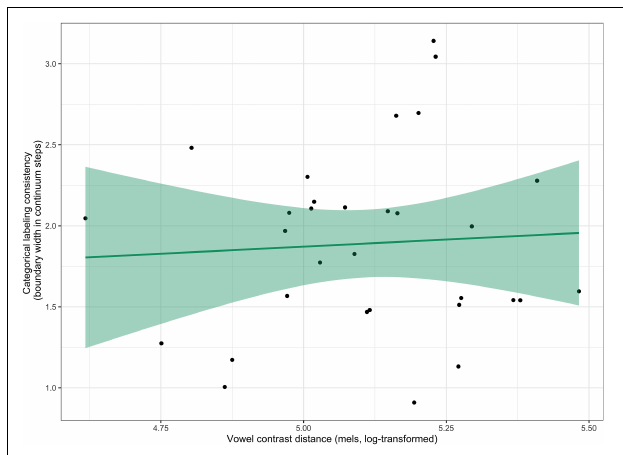
FIGURE 4 | The correlation between categorical labeling consistency and vowel contrast distance. Shaded band represents a 95% confidence interval around the best-fit